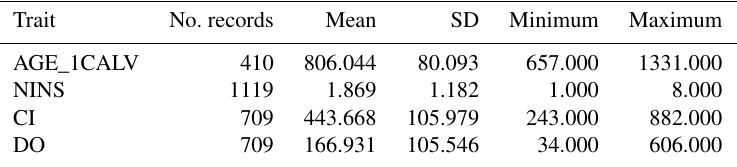
Table 2. Descriptive statistics for reproductive parameters. Trait No.